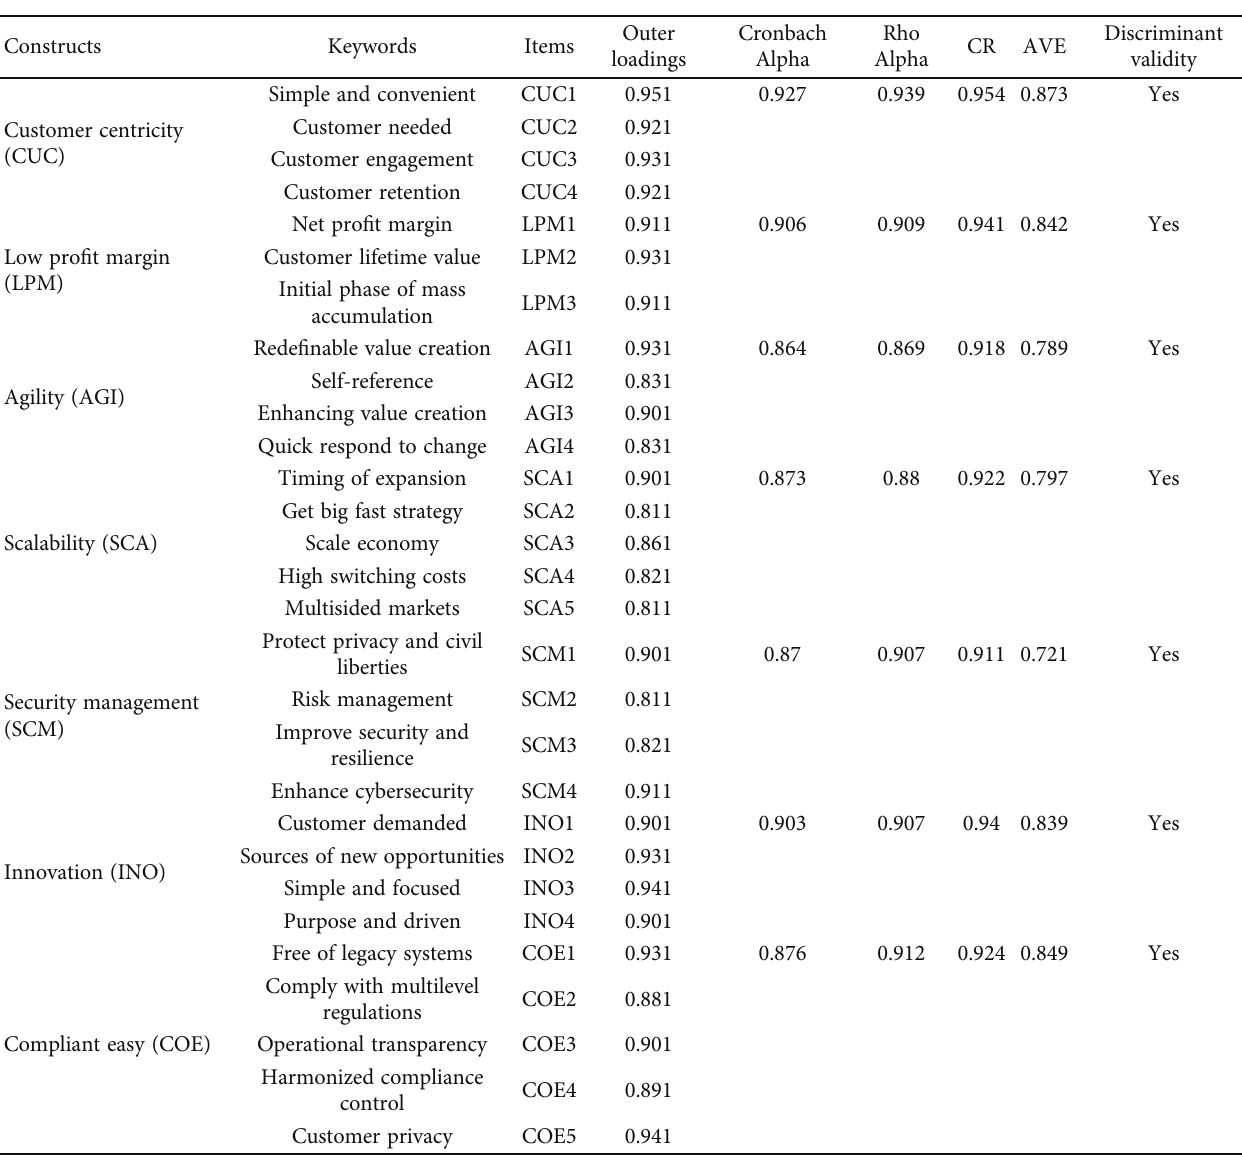
Table 3: Measurement model